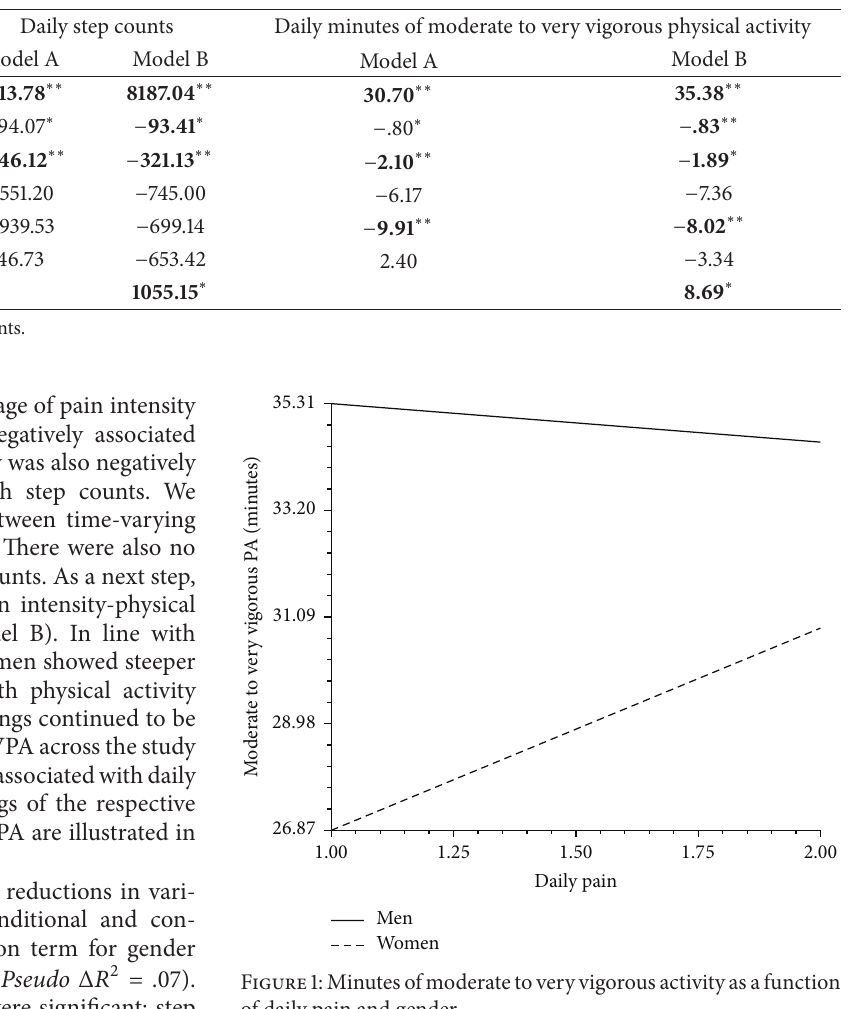
Table 2: Hierarchical linear models predicting everyday physical activity (step counts; minutes of moderate to vigorous physical activity) from person-specific and time-varying characteristics using restricted maximum likelihood estimation in HLM ( 𝑁 = 128 ).